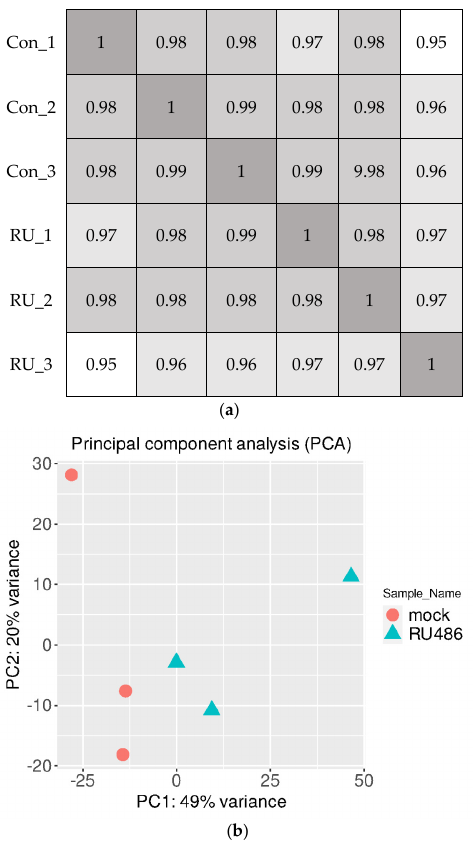
Figure 1. The correlation of RNAseq results. ( a ). Analysis of correlation between mock (con) and RU-486 (RU) treatment embryos by using Pearson correlation coe ffi cient. When R 2 > 0.95, the two samples were considered correlated. ( b ). Principal-component analysis (PCA) was conducted in the transcriptome of two di ff erent treated sample groups. The orange circle indicated the RU-486-treated group, and the blue triangle represented the control group.